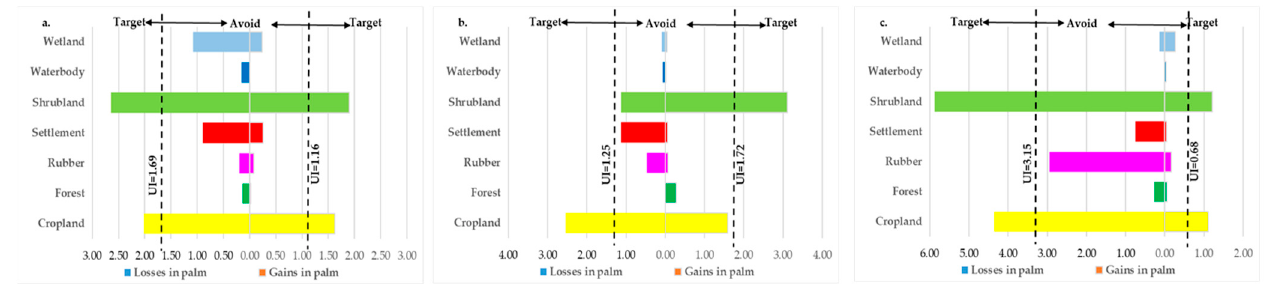
Figure 10. Transition level intensities for palm for the period ( a ) 1986–2002, ( b ) 2002–2015 and ( c ) 2015–2020 (gains on the right, losses on the left).